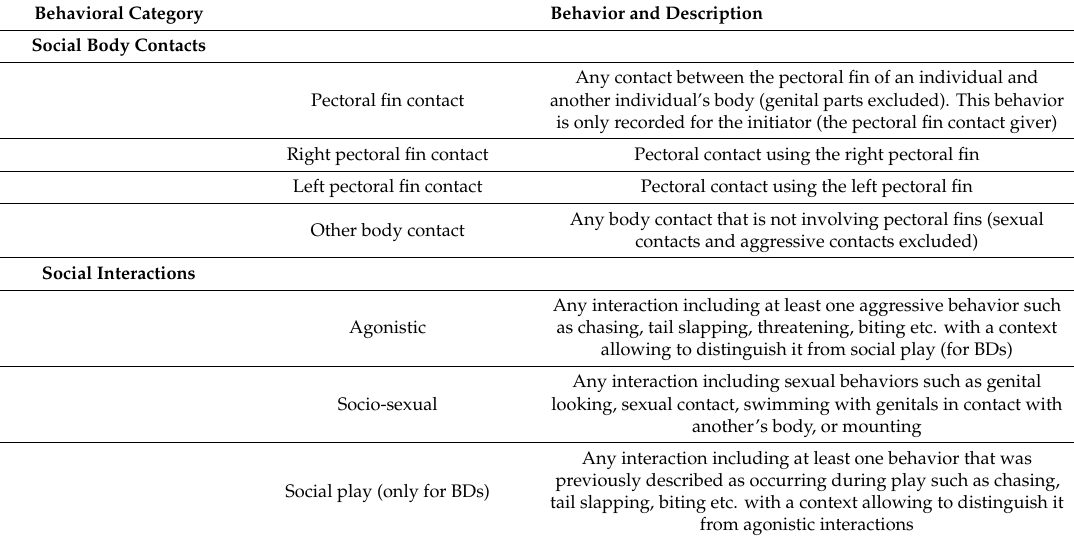
Table 2. Catalogue of social behaviors and interactions used for the video